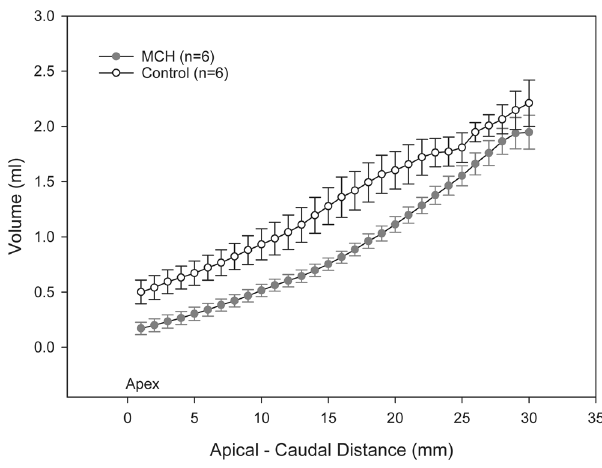
Figure 7. Comparison of regional lung volume in control and MCH – challenged animals represented as mean ± SEM per image level vs. apical – caudal distance. * p <